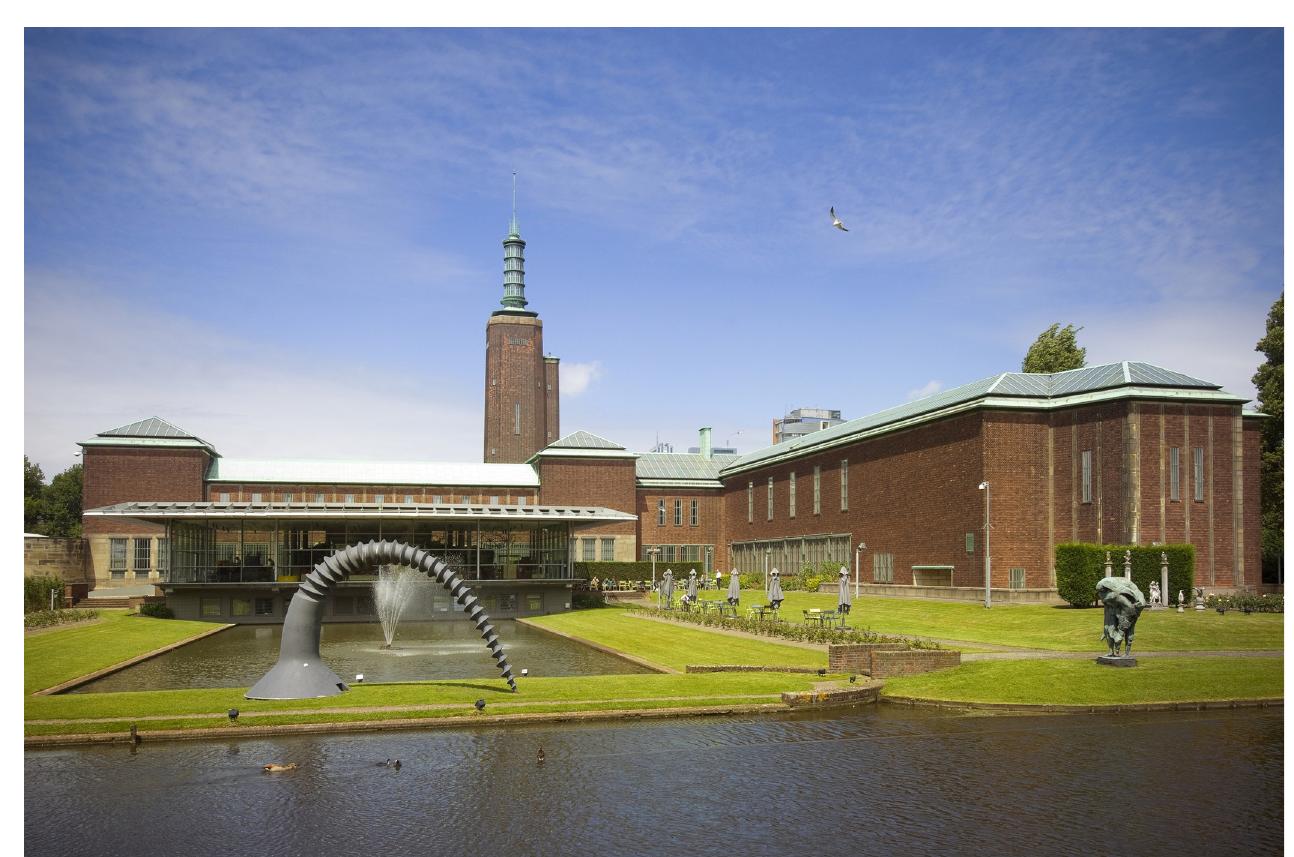
Fig 3. Exterior view of the Museum Boijmans Van Beuningen (studio Hans Wilschut 2008).